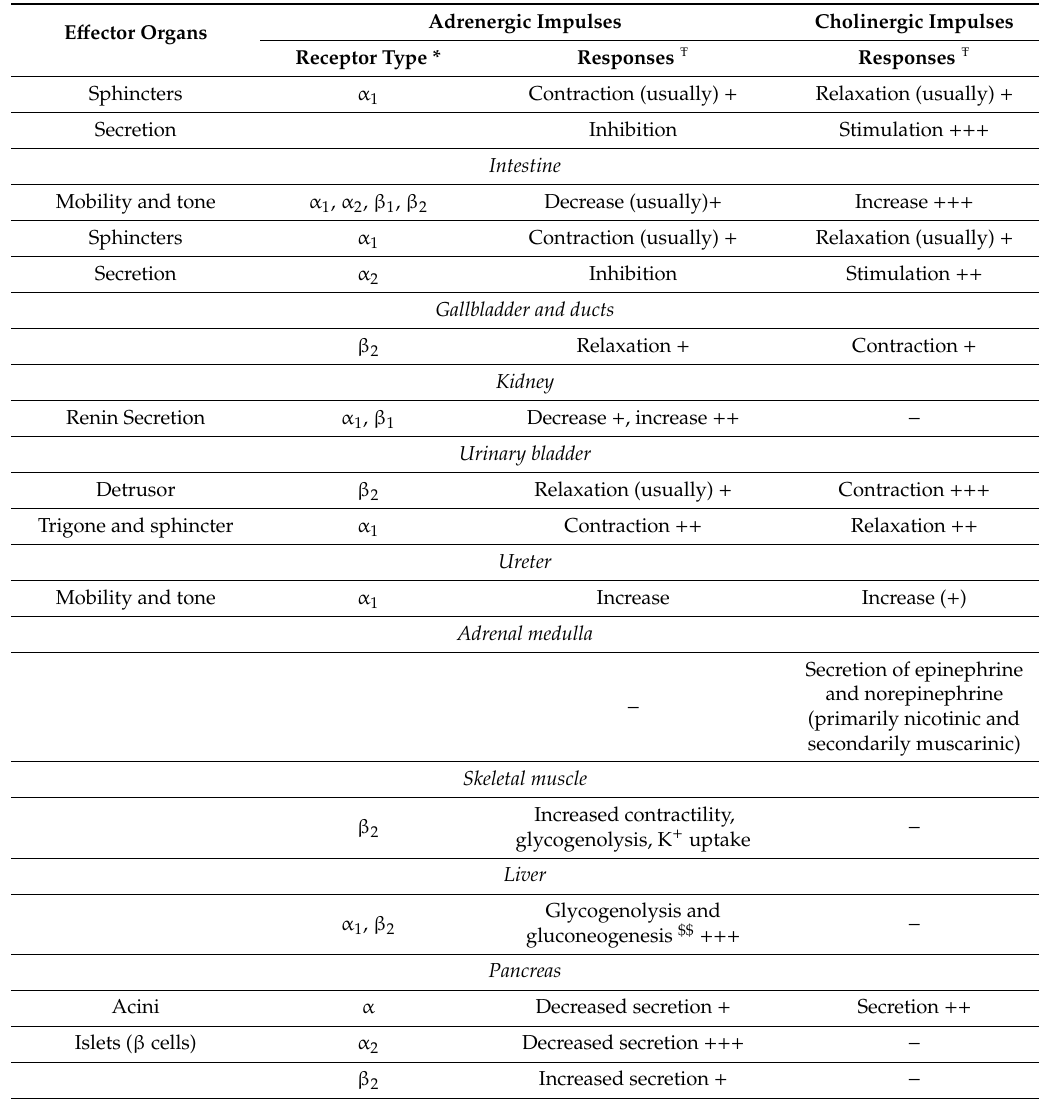
Table 1. Characteristics of subtypes of adrenergic receptors. Table 2. Cont.